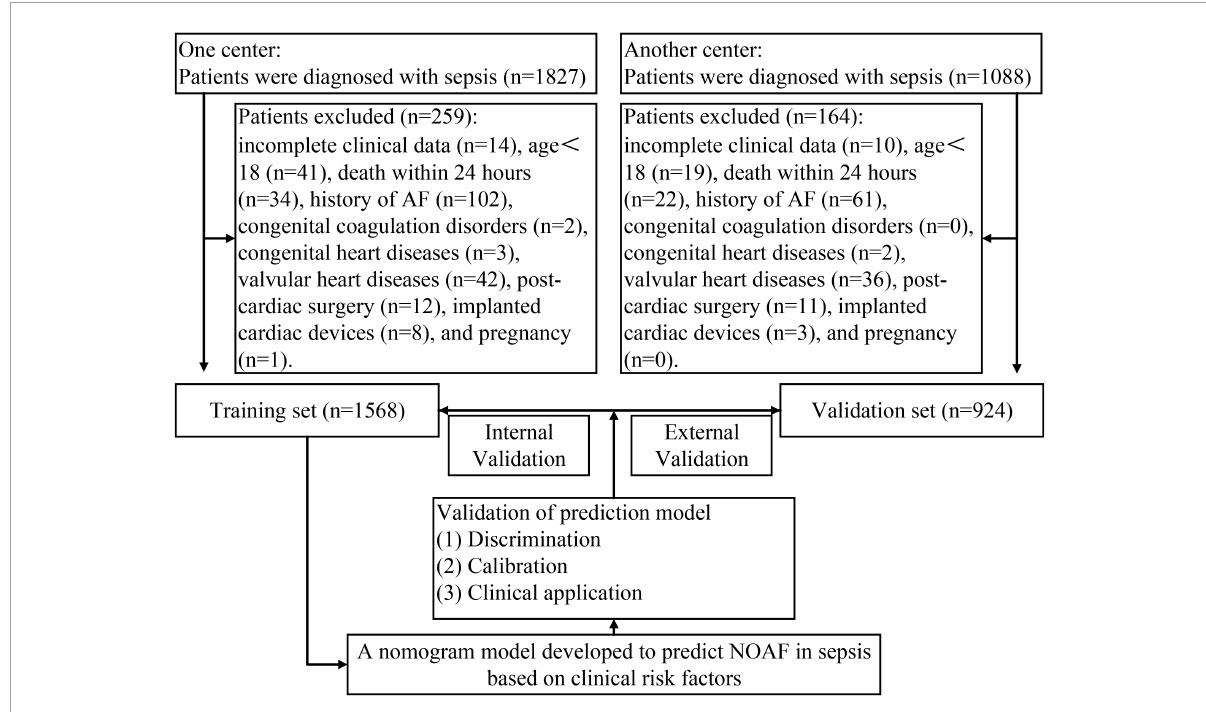
FIGURE1 The flow diagram of developing and validating the prediction model.